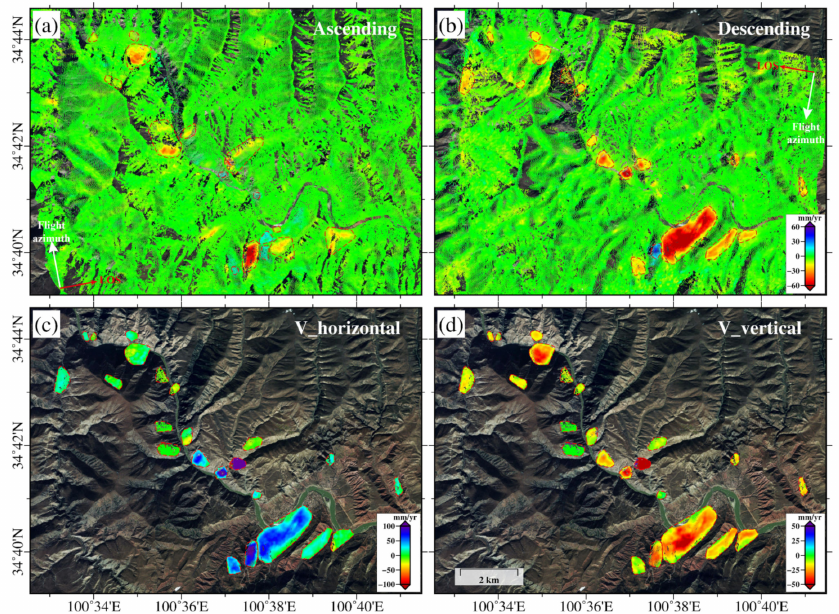
Figure 8. Average deformation velocities in the LOS direction derived from ( a ) ascending images and ( b ) descending images. ( c ) Average velocity of the horizontal deformation, with positive values indicating east or north, and ( d ) average velocity of the vertical deformation, with negative values indicating